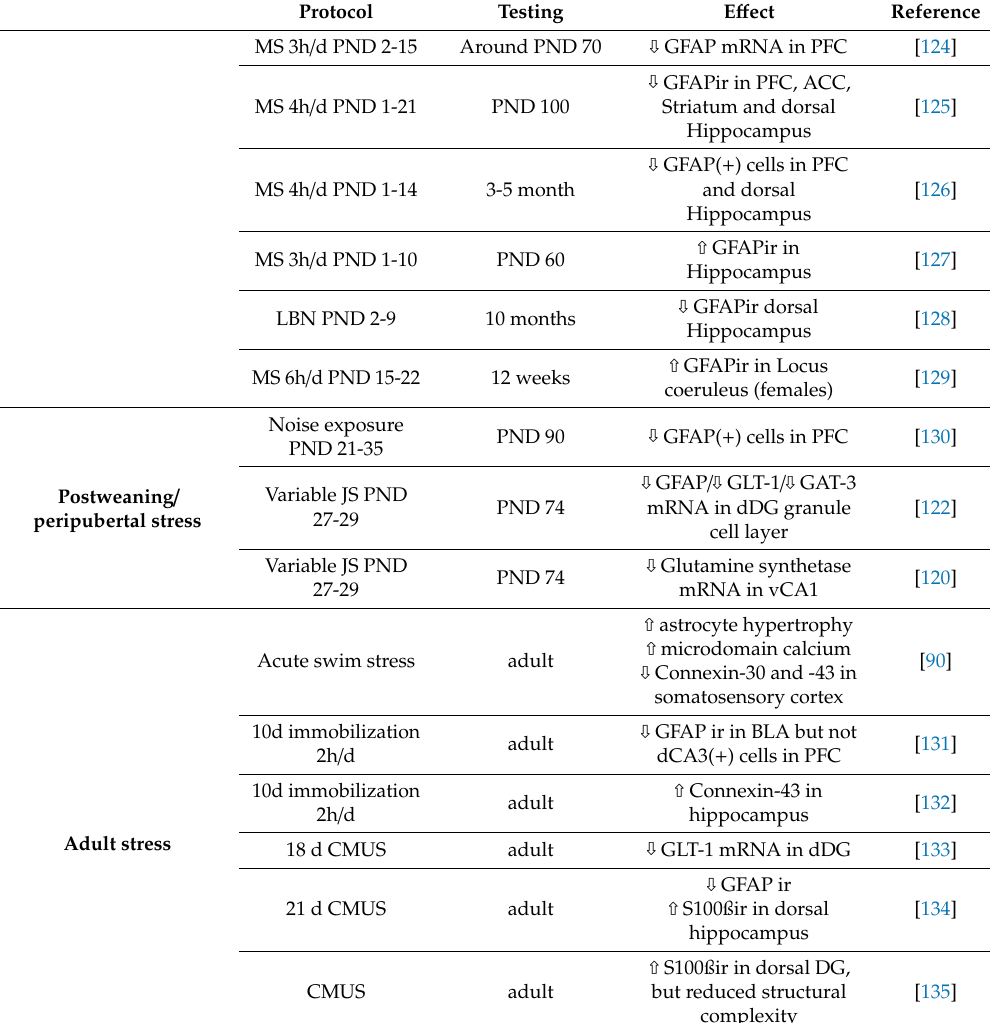
Table 1. Impact of stress across di ff erent life phases on astrocytic